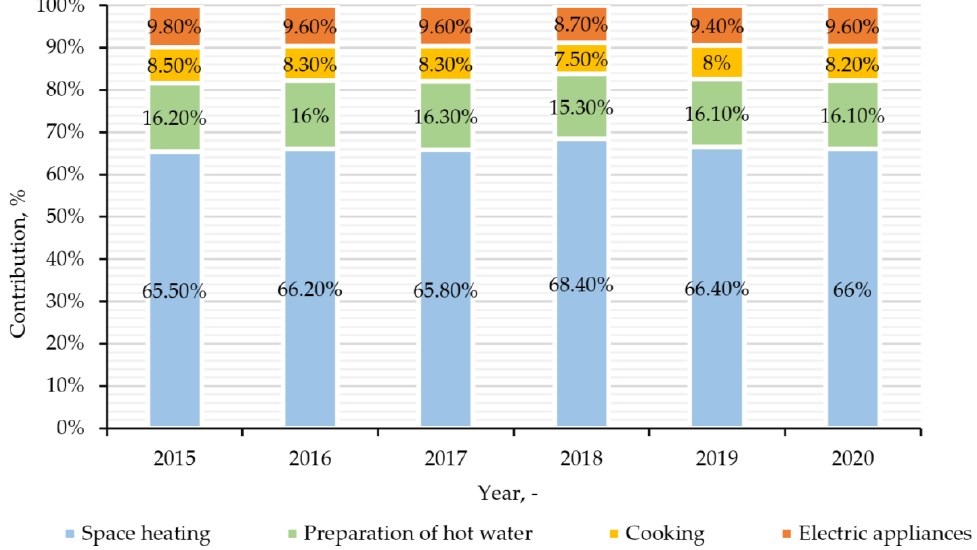
Figure 1. Structure of energy consumption in households in Poland [26].